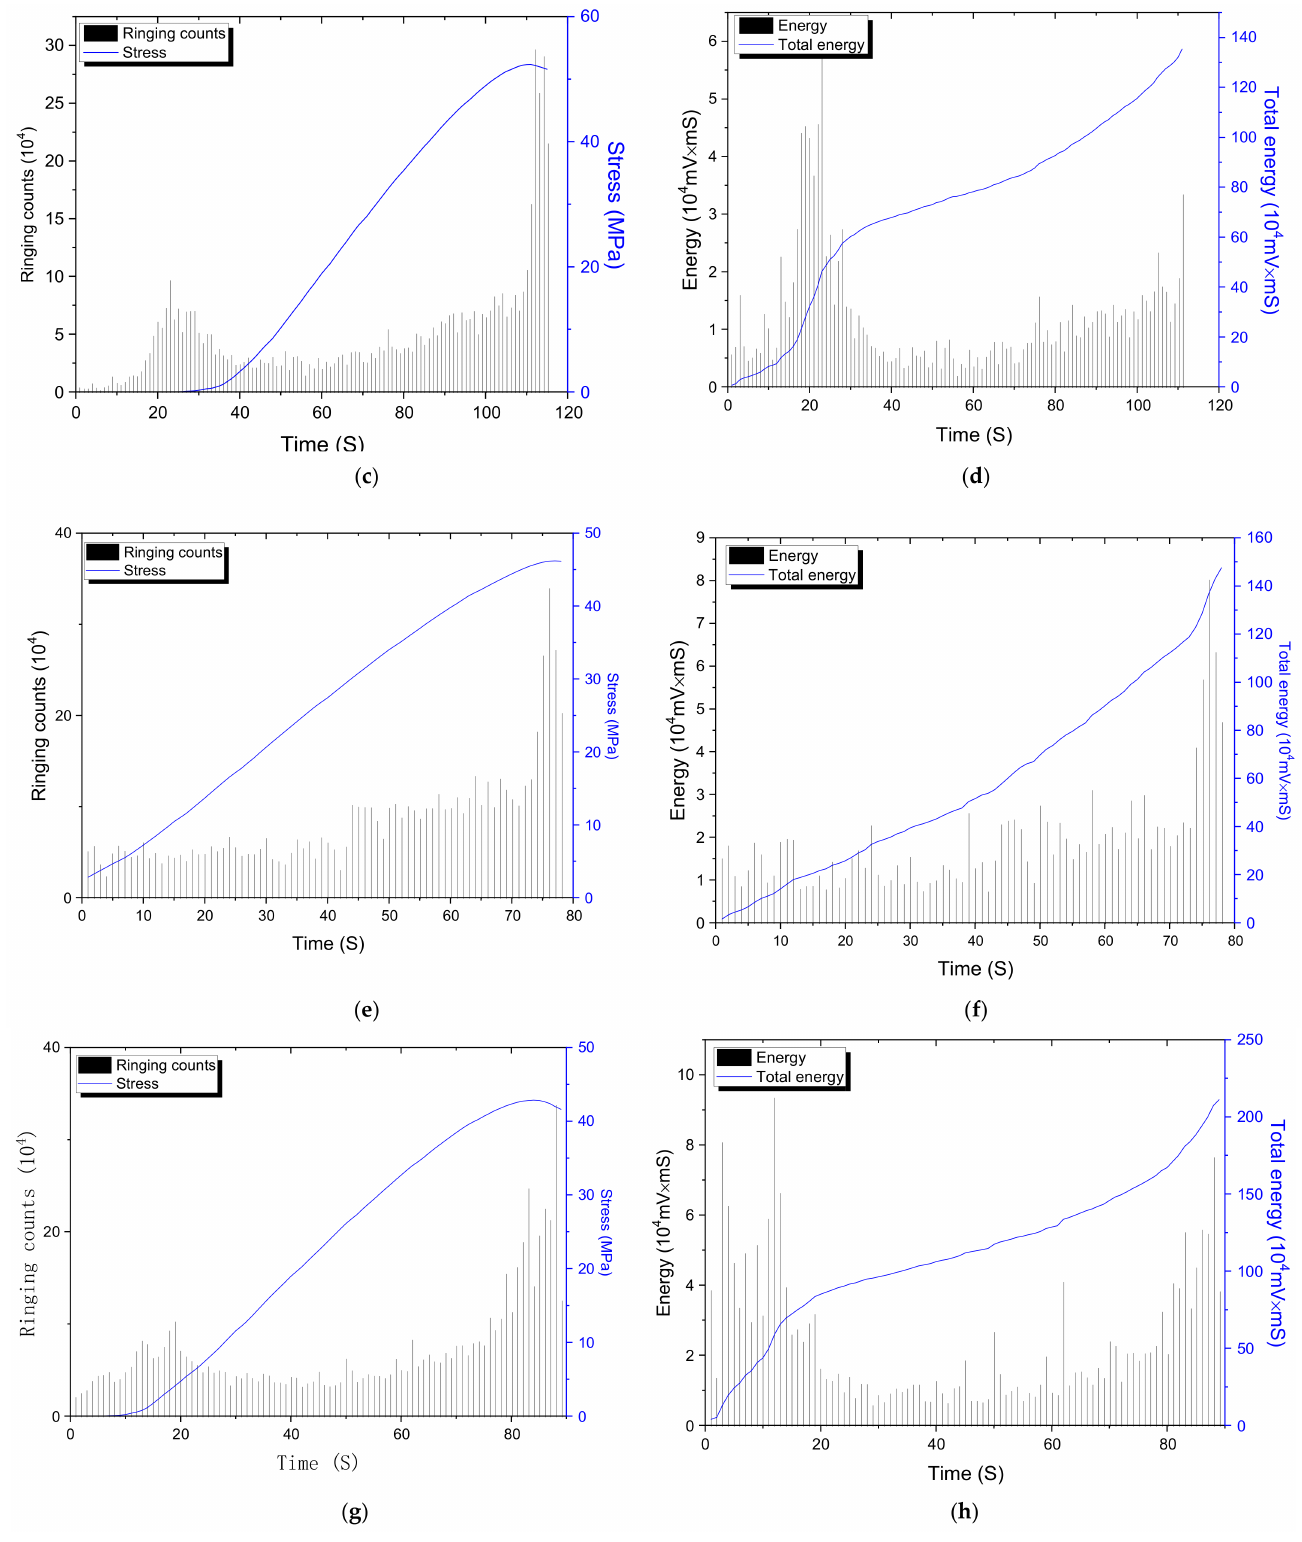
Figure 7. Counts, stress, and energy in terms of loading time of B-80% concrete samples of different pre-loading stages. ( a ) B-3-80% counts and stress development. ( b ) B-3-80% energy development. ( c ) B-7-80% counts and stress development. ( d ) B-7-80% energy development. ( e ) B-14-80% counts and stress development. ( f ) B-14-80% energy development. ( g ) B-28-80% counts and stress development. ( h ) B-28-80% energy